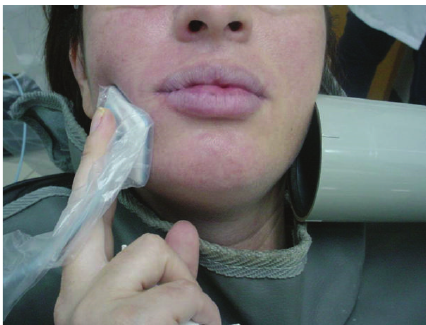
Figure 5: Extraoral technique used for final radiograph after root canal